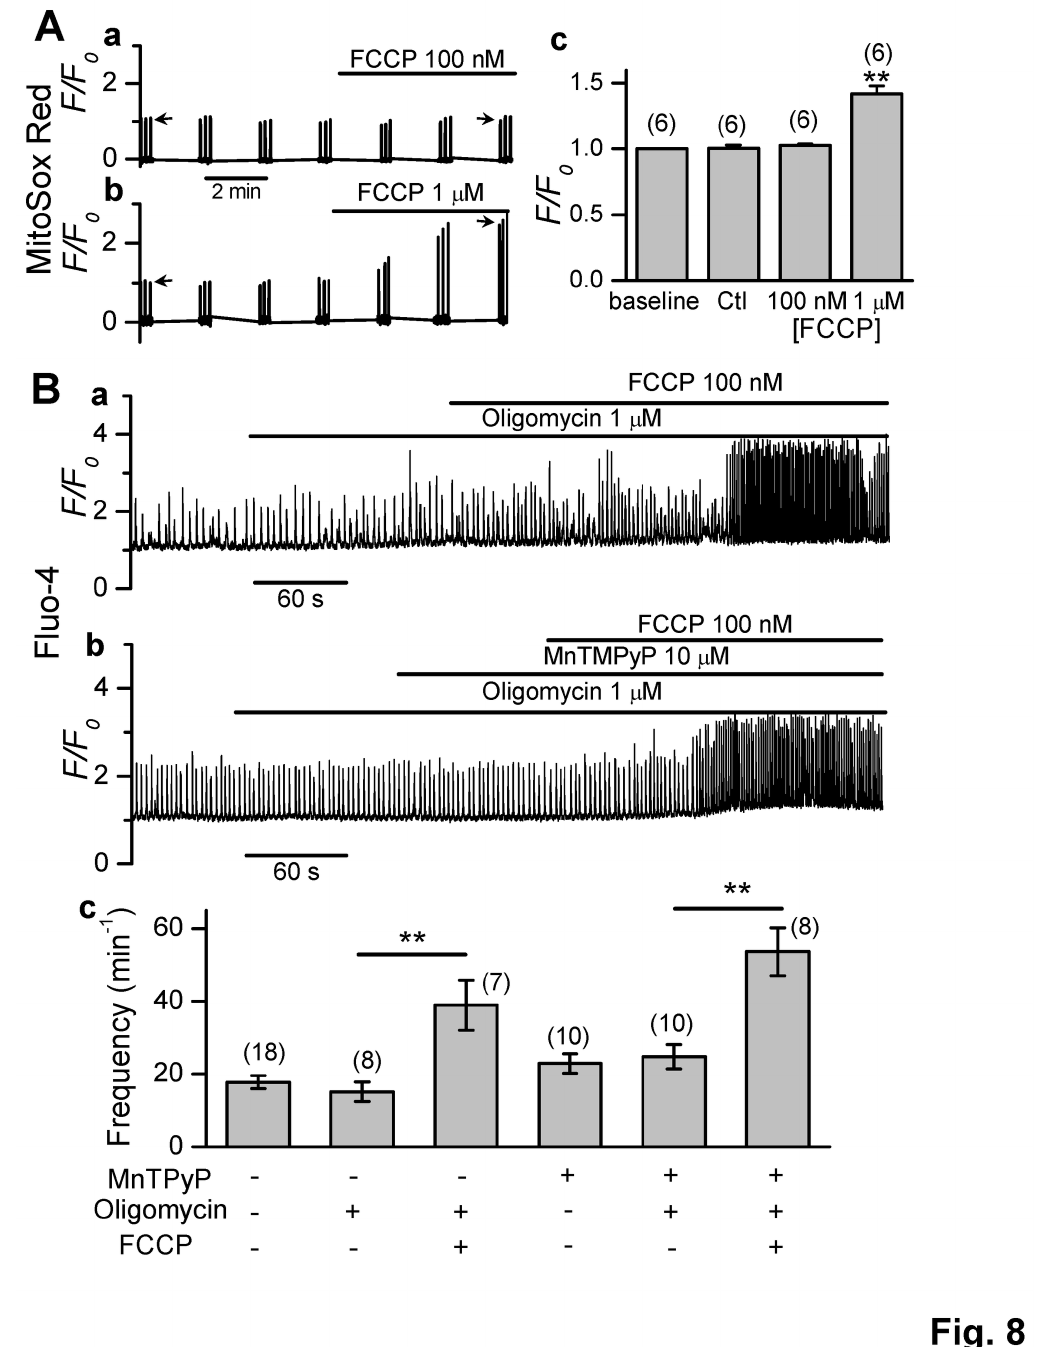
Figure 8. Less involvement of ROS in CaW facilitation by FCCP. A . Mitosox Red fluorescence (evaluation of mitochondrial superoxide level) traces recorded in mouse ventricular myocytes treated with (A- a ) 100 nM FCCP or (A- b ) 1 µM FCCP. The baseline value (i.e. before perfusion of FCCP) was normalized to 1, as indicated by the leftward-facing arrow in each panel. The F/F level at 6 min after FCCP treatment (as indicated by the rightward-facing arrow) was compared between different groups. (A- c ) 0 Summary data showing the intensity of the fluorescence (F/F ) recorded 6 min after the treatment (** p < 0.01 vs. Ctl). B . Effect of 0 MnTMPyP (10 µM) on spontaneous CaWs. Oligomycin was applied to exclude potential influences of cellular metabolic status. FCCP (100 nM) promoted CaWs either in the absence (B-a) or the presence (B-b) of MnTMPyP. (A- c ). Summary data showing the CaW frequencies under differential treatments. The cell number for measurement in each group is indicated (** p < 0.01). doi: 10.1371/journal.pone.0080574.g008 PLOS ONE |